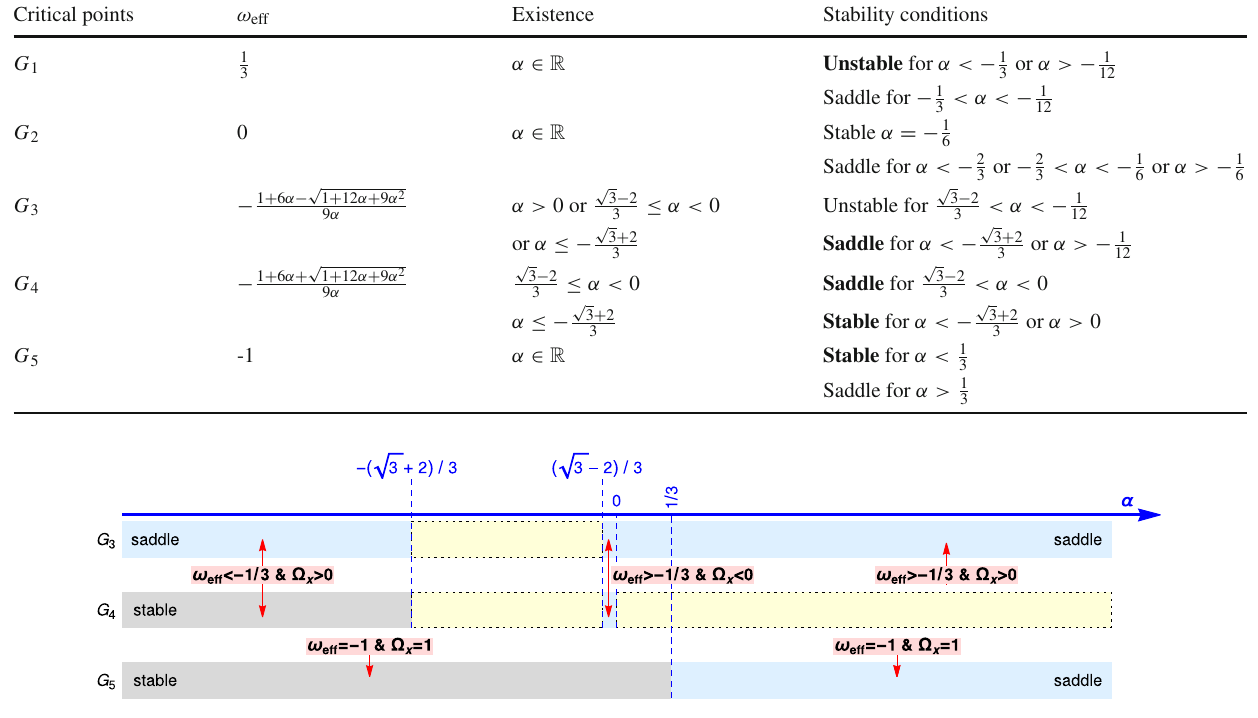
Fig. 8 Scheme of the behavior of critical points G 3 − G 5 in terms of the interacting parameter α , for model Γ 2 c . The pale blue and gray regions represent a saddle and stable critical point, respectively. The boxed pale yellow regions represent an interval where the existence conditions are not met